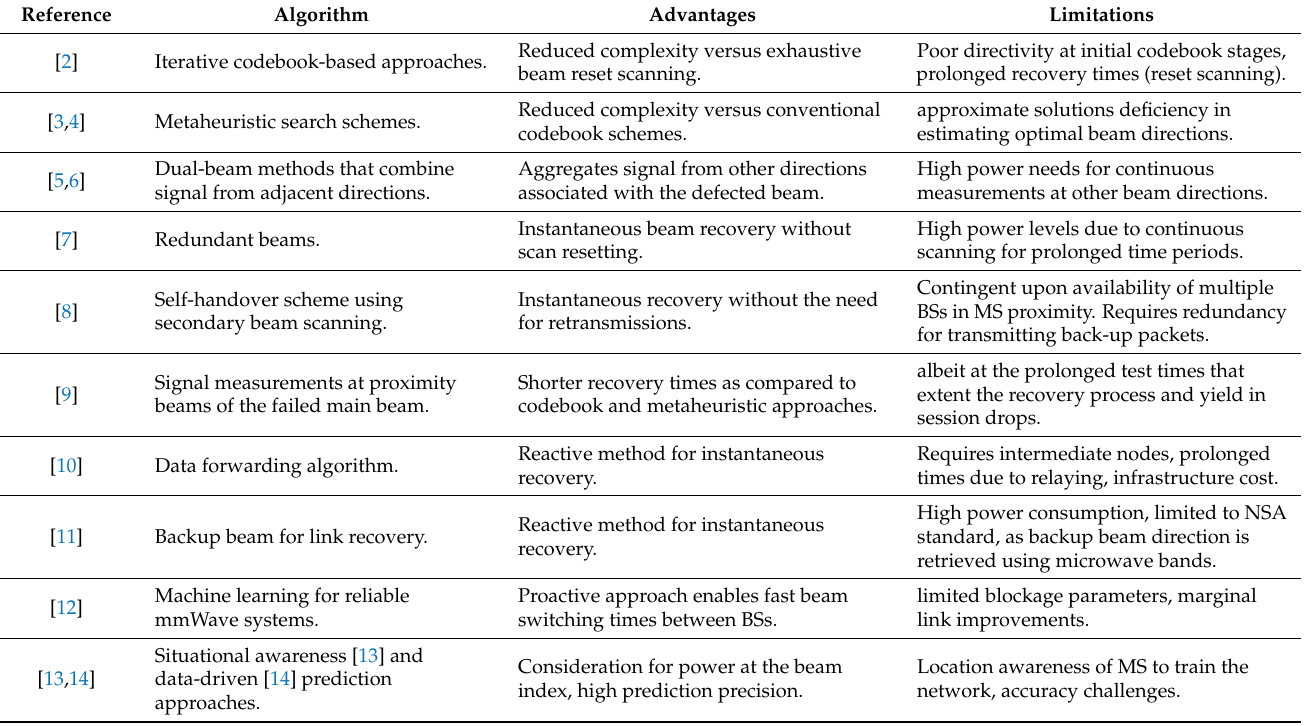
Table 1. Existing research on beam recovery techniques based on beamforming